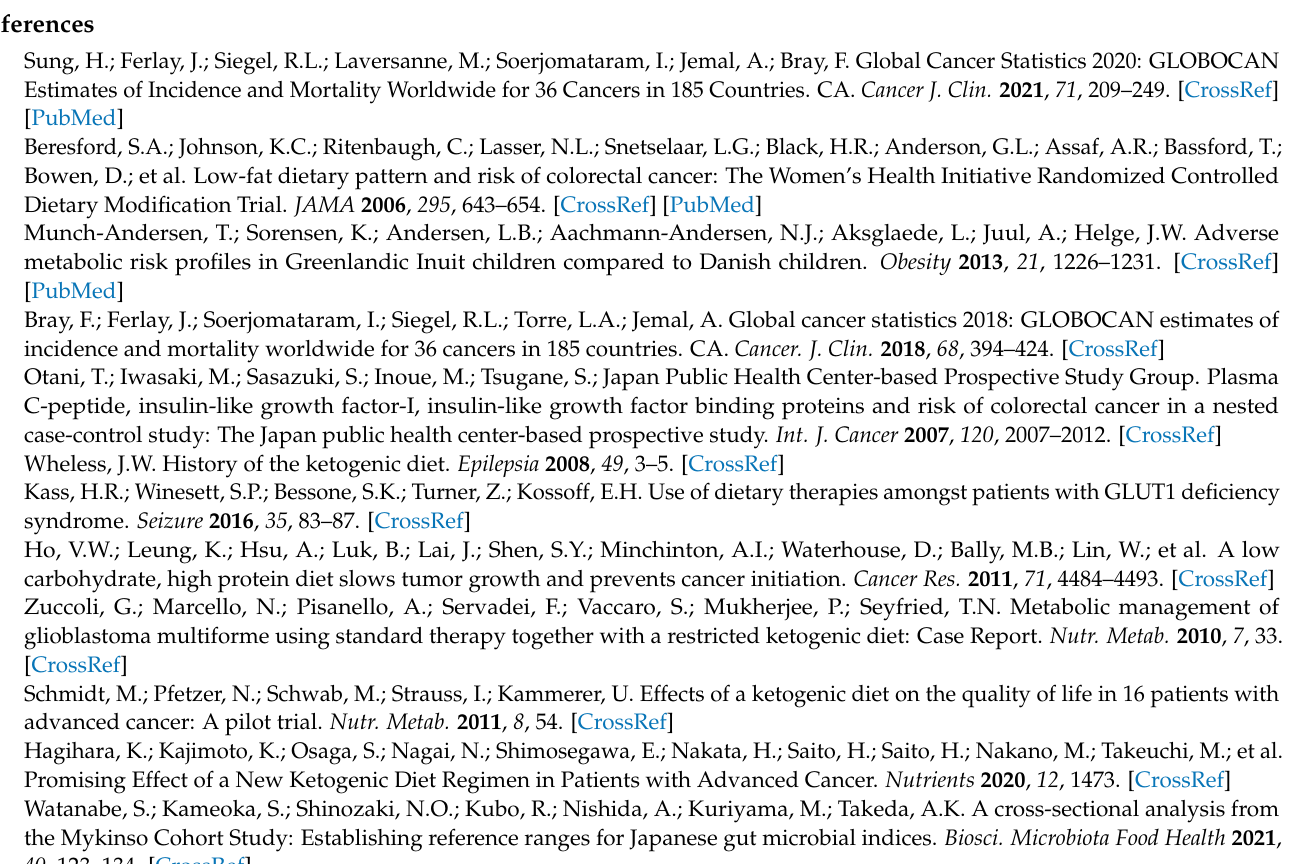
measurements; Supplemental Table S4. Analysis of body